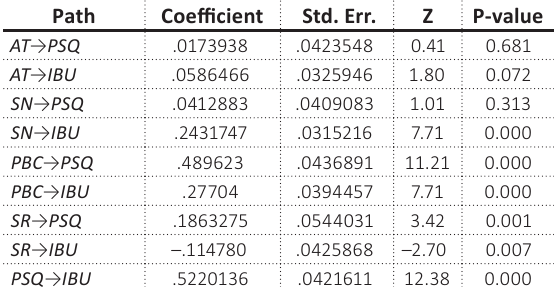
Table 4. Structural equation model without